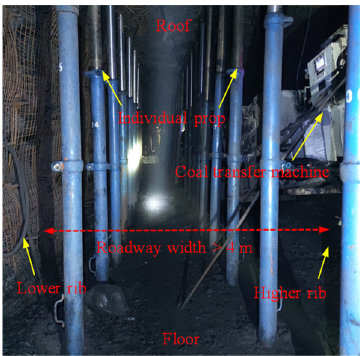
Figure 22. Advanced support section of the panel after adopting the external anchor–internal un- loading technology.